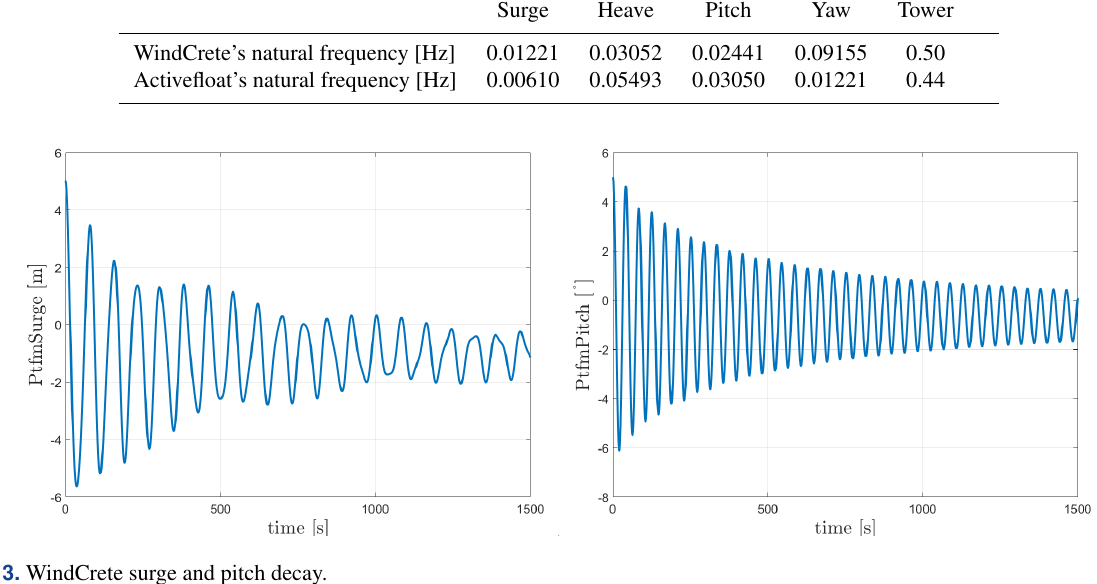
Figure 3. WindCrete surge and pitch decay.